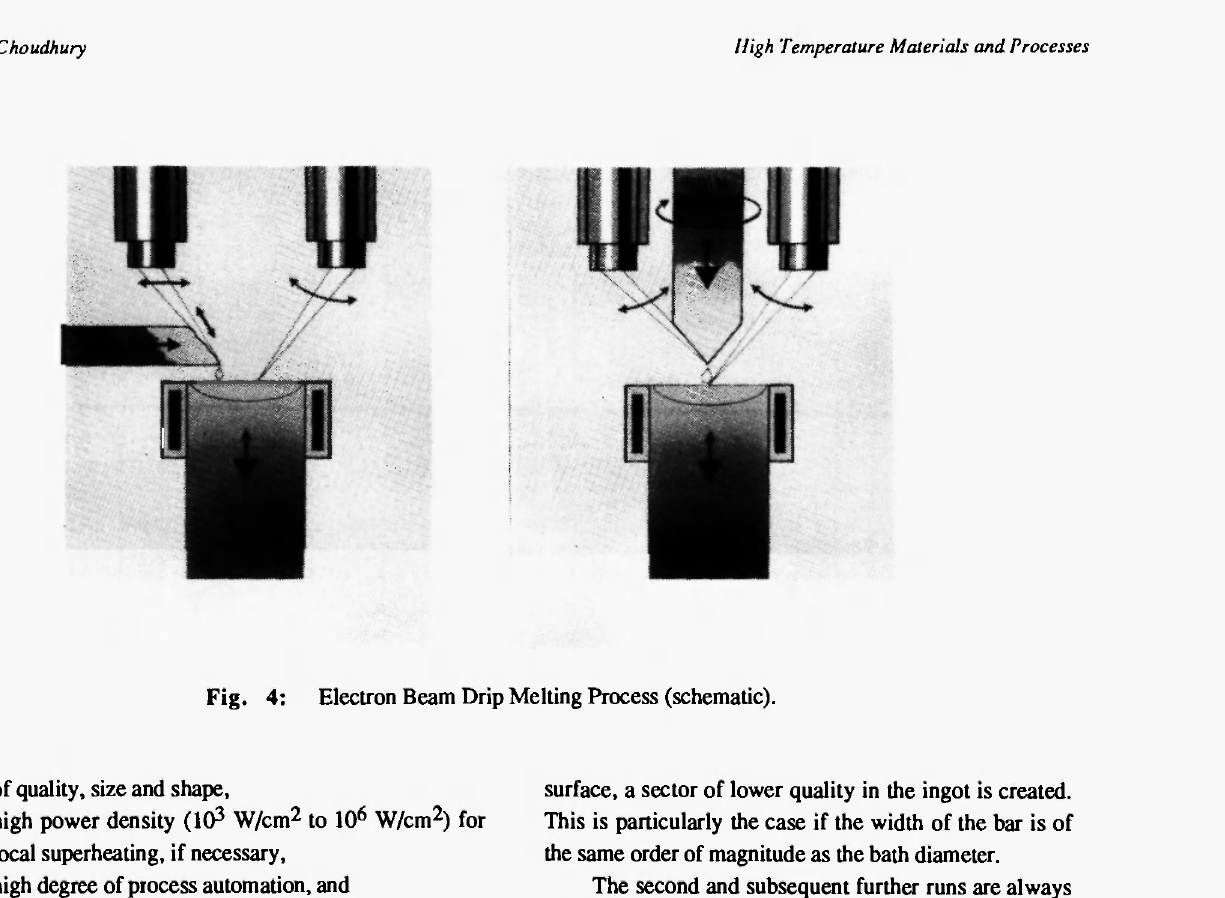
Fig. 4: Electron Beam Drip Melting Process